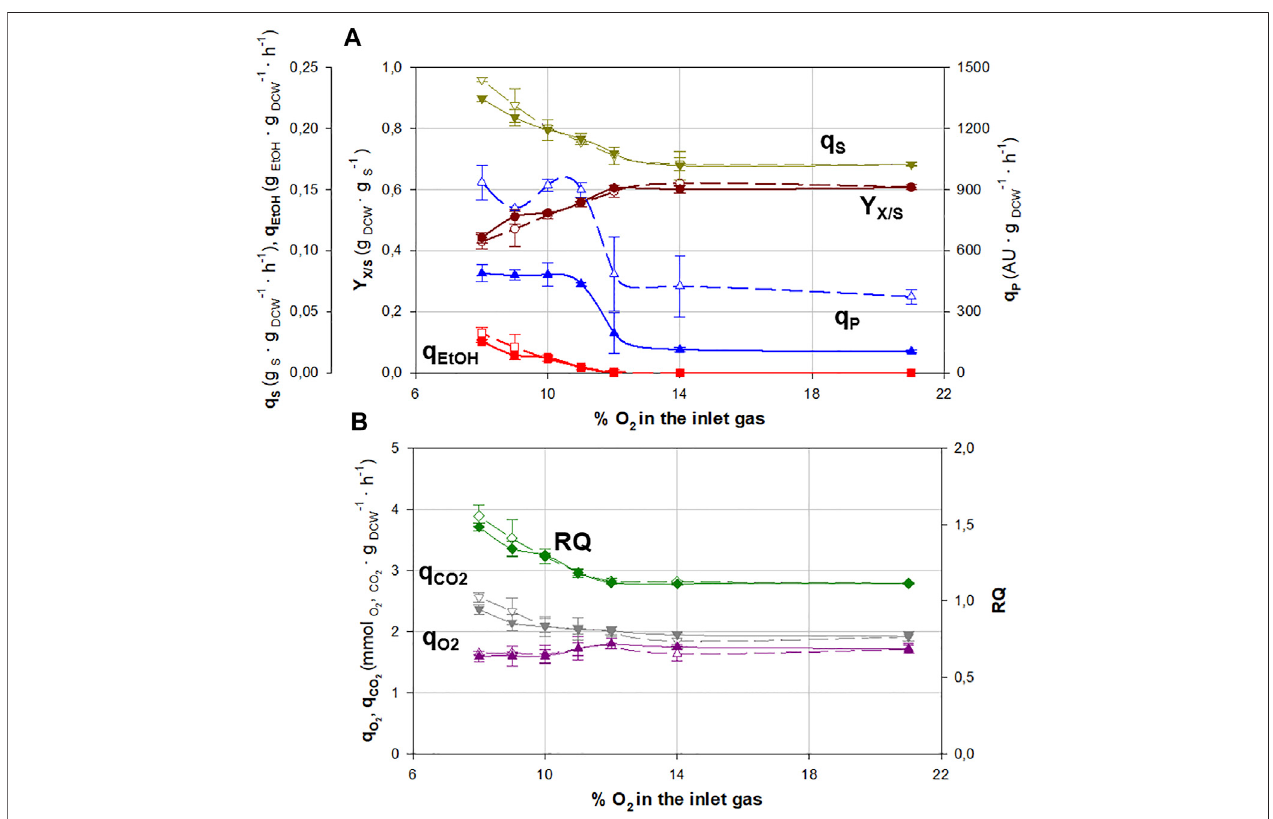
FIGURE1| Mainphysiological and production parameters for continuous cultures at differentmolarfractions ofoxygen intheinlet gasforsingle-copyclone (SCC, fi lled symbols) and multicopy clone (MCC, void symbols). (A) Speci fi c substrate consumption rate, q production rate, q EtOH ( ∎ ); and speci fi c Crl1 production rate, q P ( ▲ ). (B) Respiratory quotient, RQ ( ◆ ); speci fi c oxygen consumption rate, qO 2 ( ▲ ); and speci fi c carbon dioxide production rate, qCO 2 ( ▼ ). Error bars represent the SD of biological